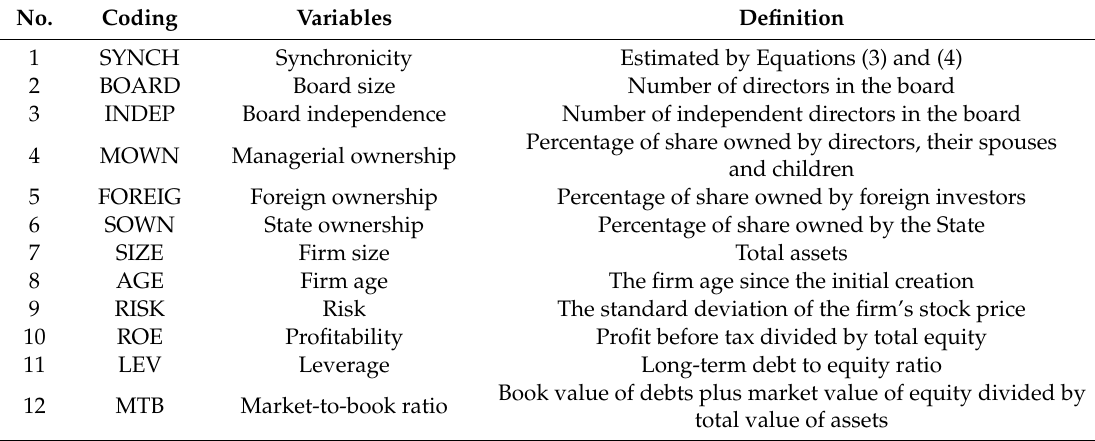
Table 1. Illustration of